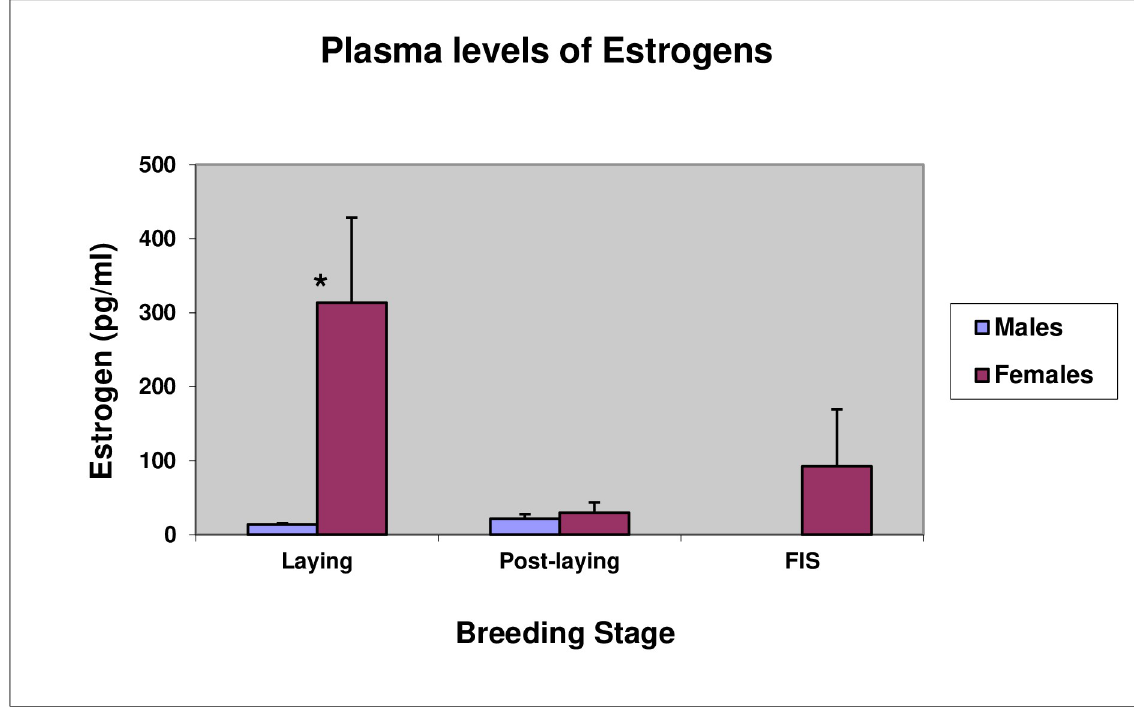
Fig 13. Mean ( ± se) plasma levels of estrogens (pg/ml) during the laying, post-laying, and first incubation spell (FIS). � indicates that the difference between estrogen levels in males and females is significant (P <